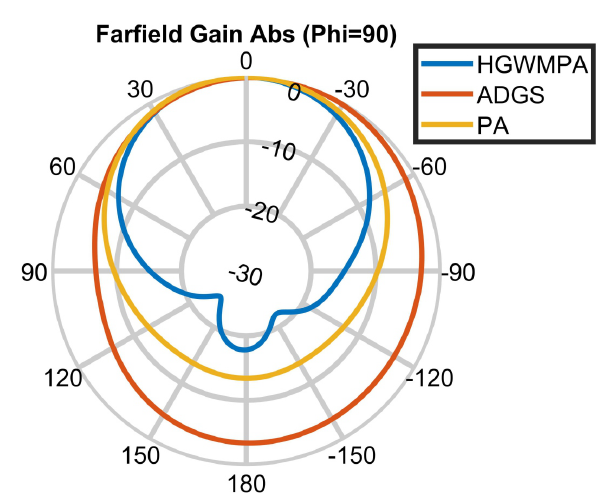
FIGURE 8. Normalized radiation patterns of the PA, ADGS and HGWMPA at 5.4 GHz (Phi=90 deg. plane).